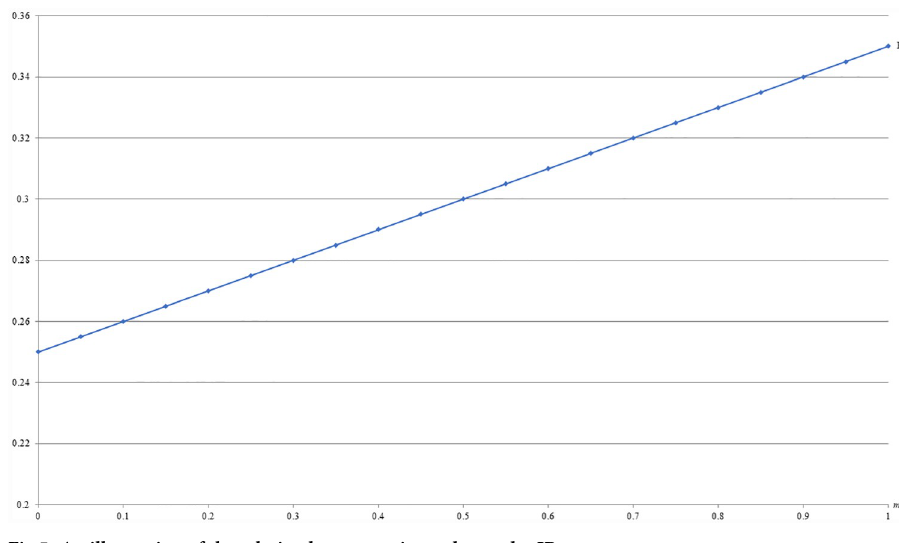
Fig 5. An illustration of the relation between price and m under